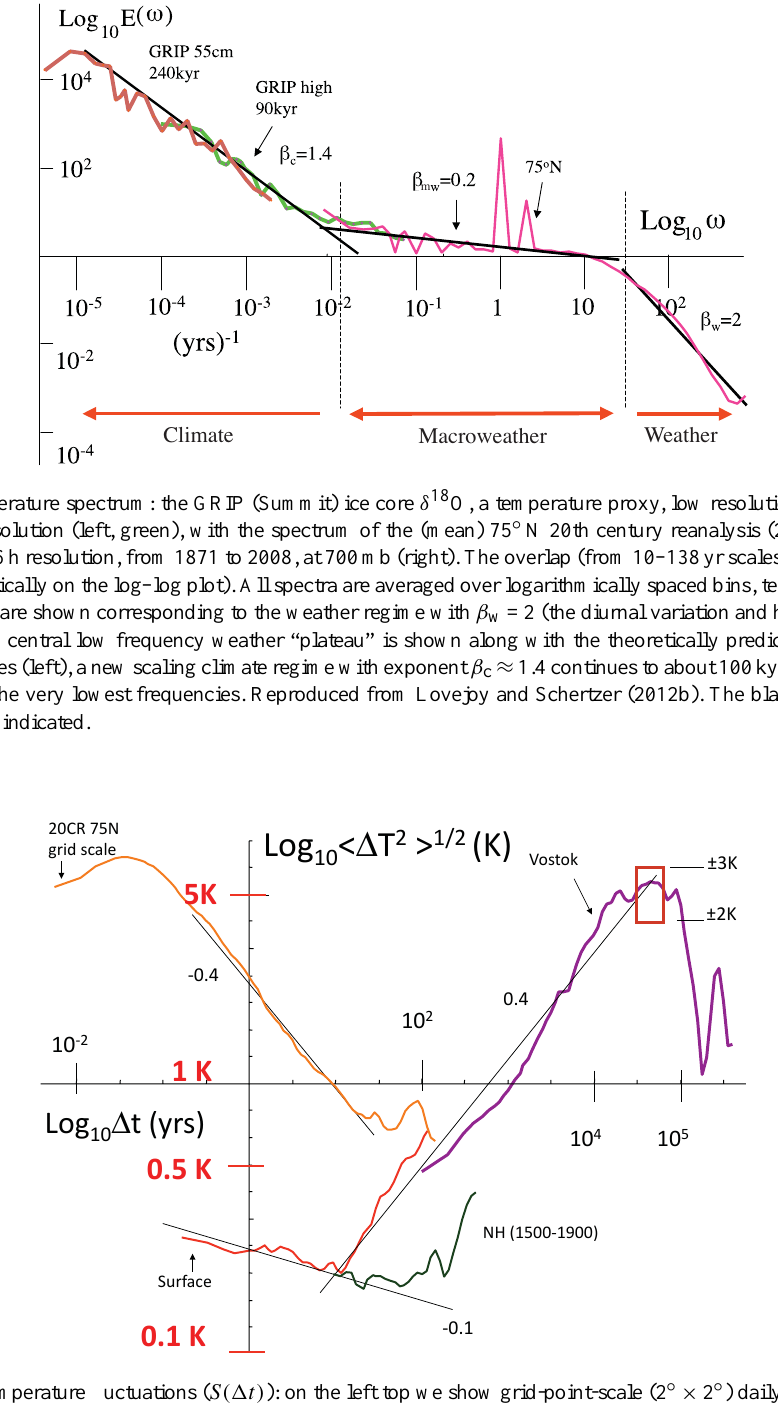
Fig. 3. Empirical RMS temperature fluctuations ( S(1t) ): on the left top we show grid-point-scale (2 ◦ × 2 ◦ ) daily scale fluctuations for both 75 ◦ N and globally averaged along with reference slope ξ (2)/2= − 0.4 ≈ H (20CR at 700mb). On the lower left, we see at daily resolution, the corresponding globally averaged structure function. Also shown (bottom) are the average of the three in situ surface series as well as three multiproxy structure functions described in Lovejoy and Schertzer (2012b) (the ensemble average of the RMS fluctuations of the Huang, 2004, Moberg et al., 2005, and Ljundqvist, 2010, multiproxies). The surface curve is the mean of three surface series (NASA GISS, NOAA CDC and HADCRUT3, all 1881–2008). At the right we show the Vostok palaeotemperature series. Also shown is the interglacial “window”. This is a simplification of a figure in Lovejoy and Schertzer